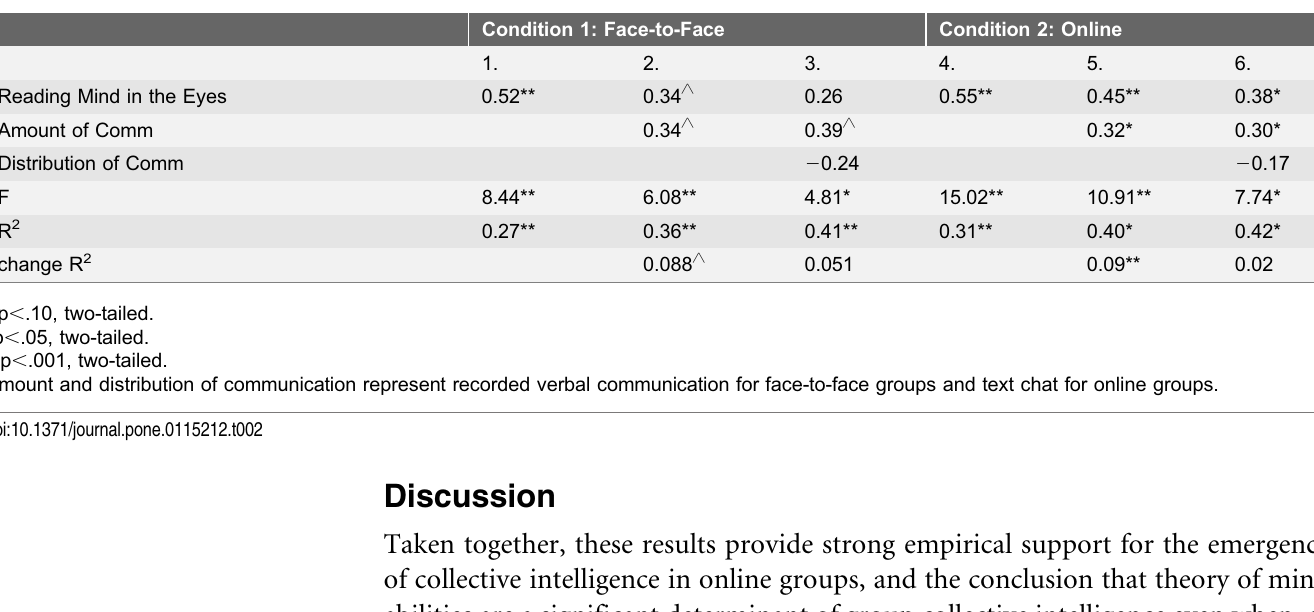
Table 2. Results of OLS Regressions of collective intelligence on the average Reading the Mind in the Eyes (RME) score, the amount of communication, and the distribution of